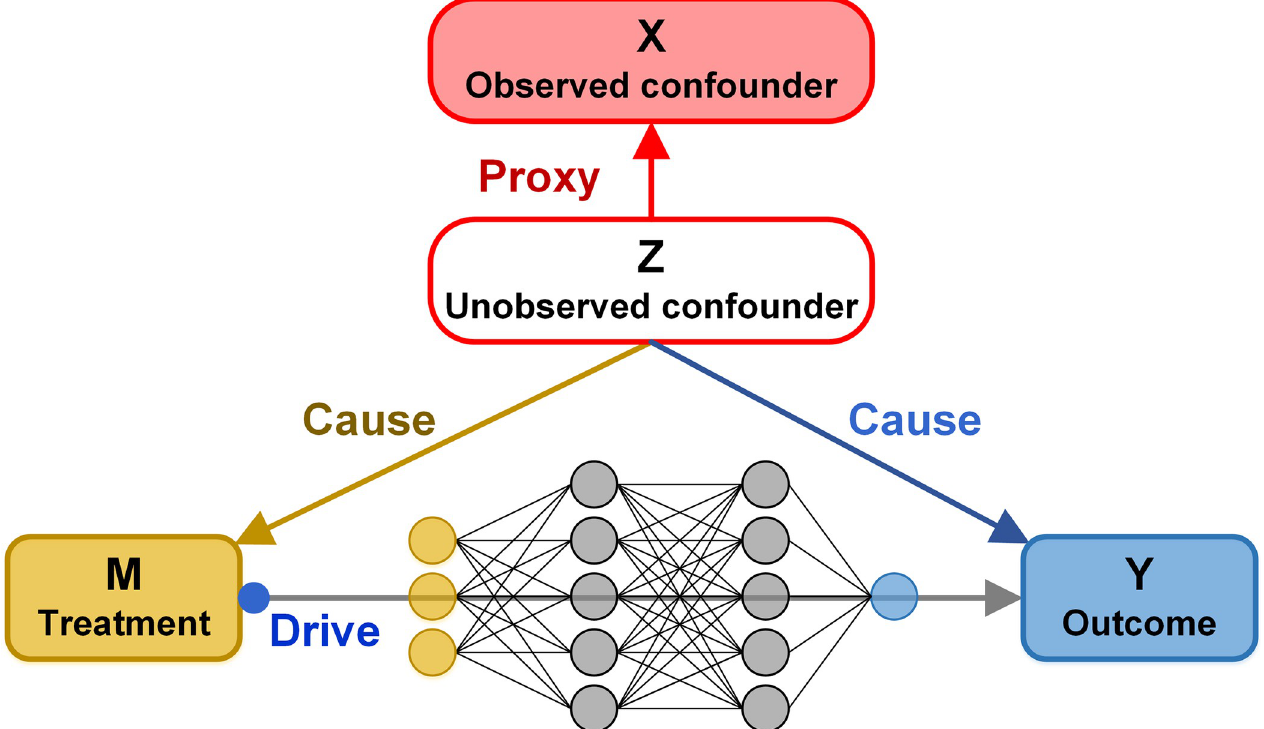
Fig 1. The causal structure of the mutation in the cancer biological process. M is a binary treatment variable, i.e., whether a gene mutated or not; Y is the outcome, e.g., the cell proliferation activity. X is the observed confounders, i.e., the mutation matrix of covariant genes; Z is the unobserved confounders which can be learned from X , e.g., micro-environment stress, so another role for X is a proxy variable for Z ; Confounder affect both the treatment and the outcome and may lead to the erroneous association.